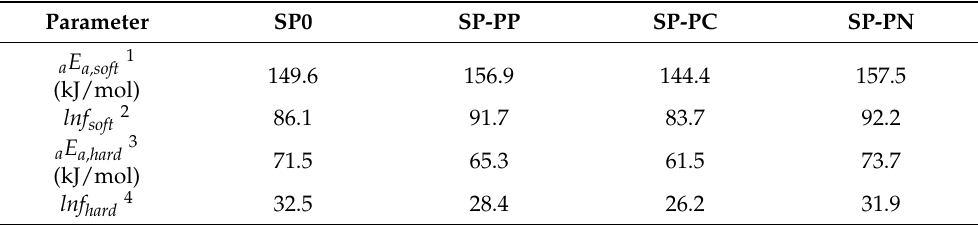
Figure 6. Dependences of storage modulus ( E ′ ), loss modulus ( E ″ ) and loss factor ( tan δ ) on the temperature for SP-PP propellant for different frequencies. Table 7. Apparent activation energies and pre-exponential factors of soft and hard segments of obtained propellants.